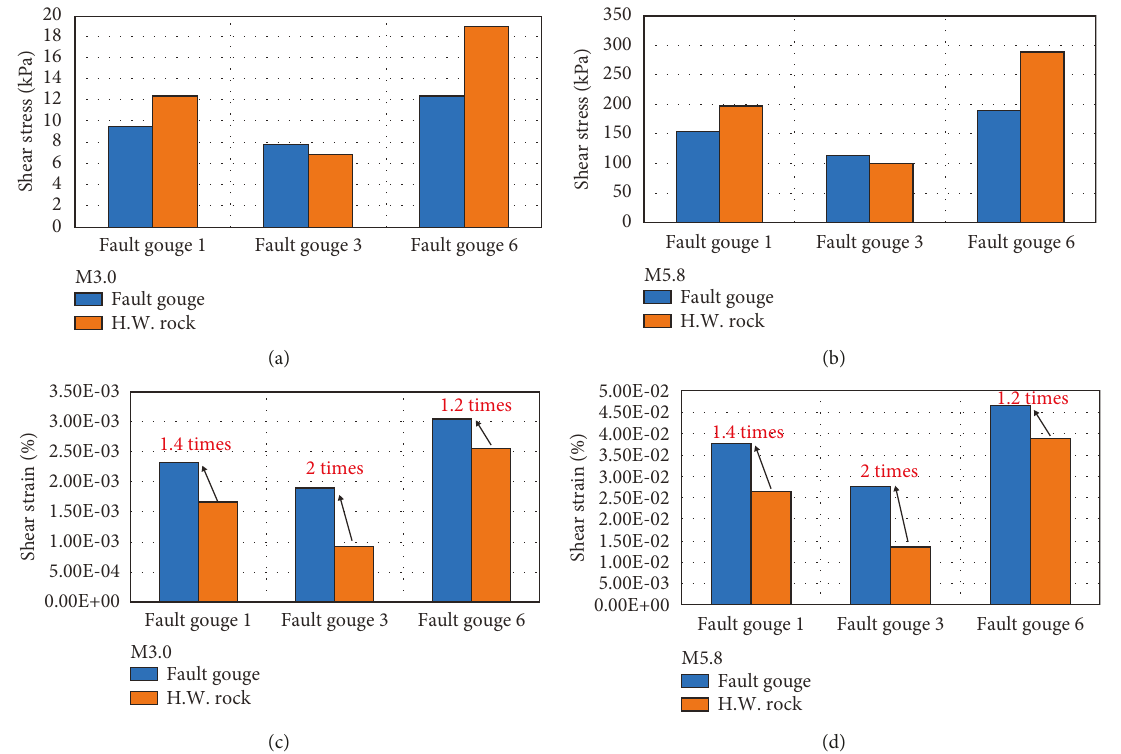
Figure 14: Comparison of the maximum shear stress and shear strain between the fault gouge in granite and H.W. rock due to the (a) M3.0 and (b) M5.8 earthquakes. There is a similar tendency in all of the fault gouges, regardless of magnitude. (a) Maximum shear stress due to the M3.0 earthquake. (b) Maximum shear stress due to the M5.8 earthquake. (c) Maximum shear strain due to the M3.0 earthquake. (d) Maximum shear strain due to the M5.8 earthquake. Table 5: Dynamic shear modulus of highly weathered rock and fault gouge in granite and sedimentary rock. The dynamic shear moduli of highly weathered rock and fault gouge are similar in sedimentary rock, whereas there is a large difference between the dynamic shear moduli of highly weathered rock and fault gouge in granite. Rock type Dynamic shear modulus (MPa)